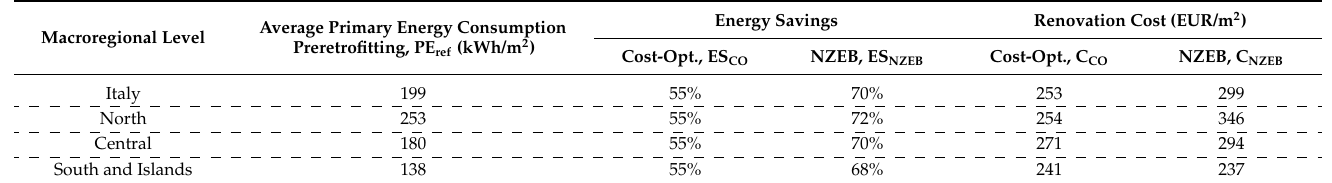
Table 7. Main input data for MFH (preretrofitting primary energy, percentual energy savings and renovation costs) collected for the Italian macroregions.